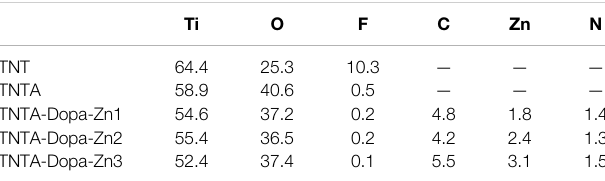
TABLE 1 | Surface element concentration (wt%) of the different samples characterized by